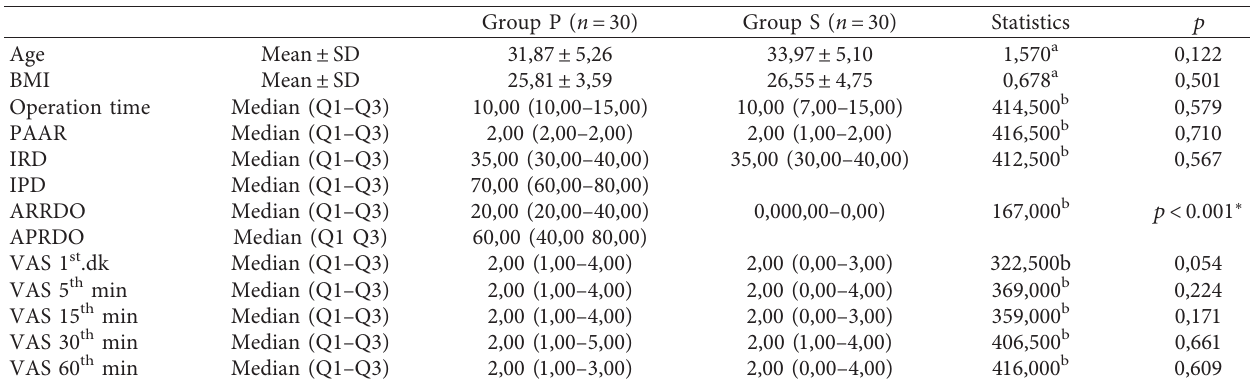
Figure 1: The CONSORT flow diagram of groups. CONSORT: Consolidated Standards of Reporting Trials. Group P: propo- fol +remifentanil. Group S: sevoflurane Table 1: Sociodemographic and clinical data of patients.